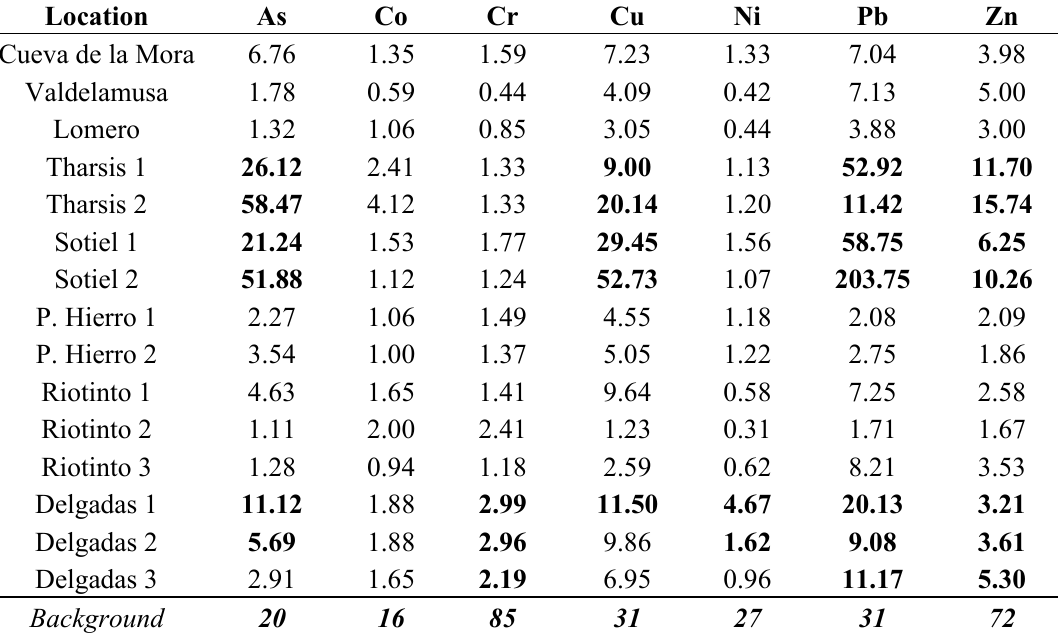
Table 13. Enrichment factor for soil samples of Iberian Pyrite Belt